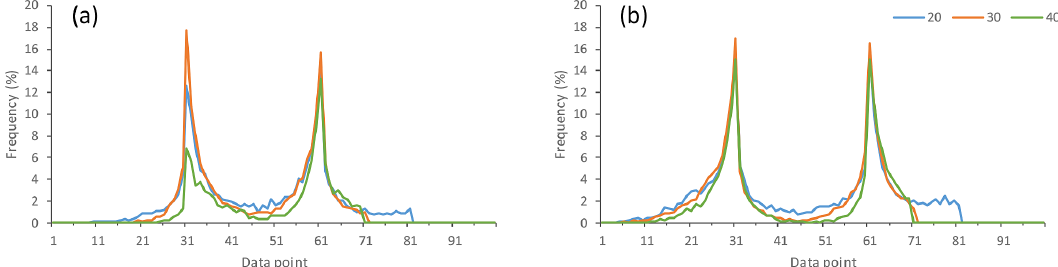
= (1 , 3 , 1) and (b) σ 2 = (3 , 1 , 3). j j